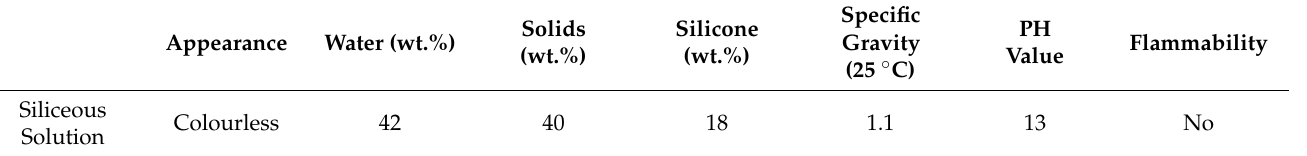
Table 3. Main components of siliceous solution.